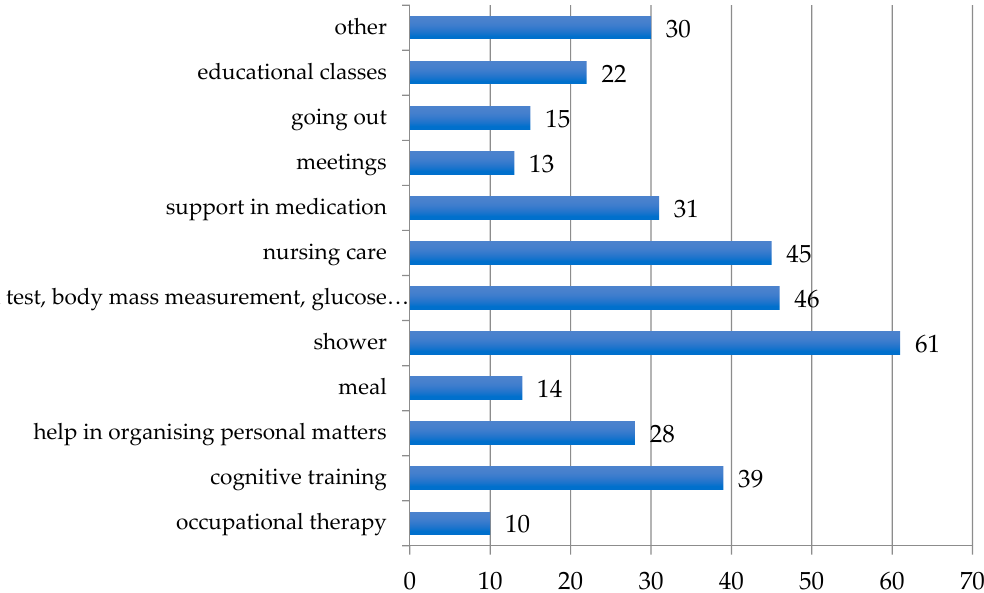
Figure 3. Unavailable services in the opinion of the attendees of day care centres in Poland. Abbreviations: RR, blood pressure.